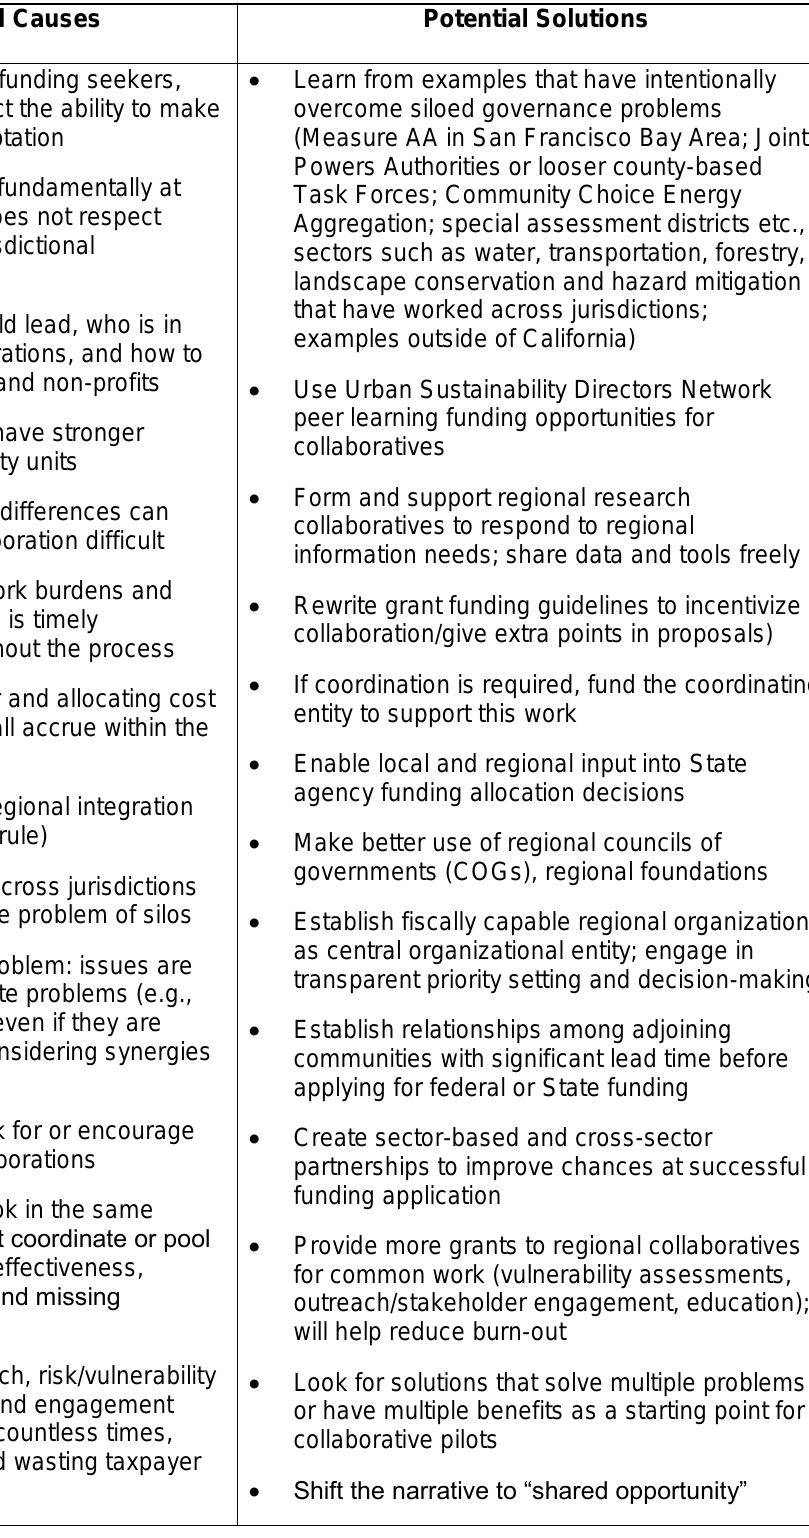
Table A2.9: Characteristics, Underlying Causes and Potential Solutions to Address the Siloed Government